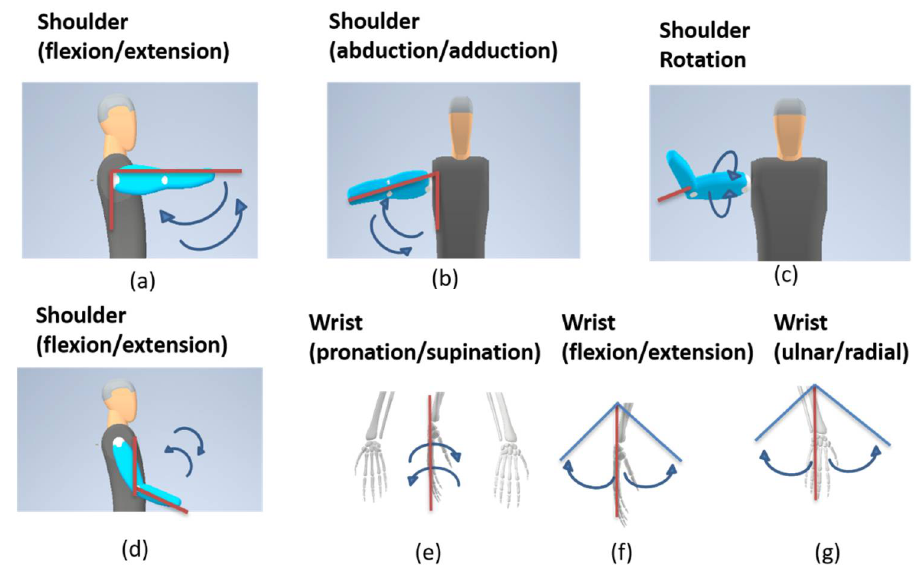
Figure 2. Human upper limb anatomical rotations: ( a ) shoulder flexion/extension; ( b ) shoulder abduction/adduction; ( c ) shoulder rotation; ( d ) shoulder flexion/extension; ( e ) wrist pronation/supination; ( f ) wrist flexion/extension; ( g ) wrist ulnar/radial.